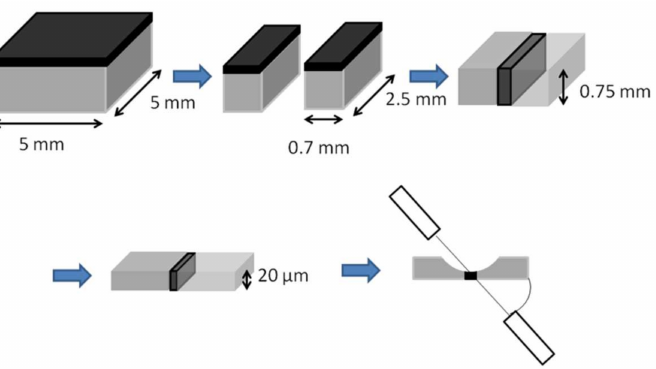
Figure 1. Sample preparation method used to examine the electrode/electrolyte interface by